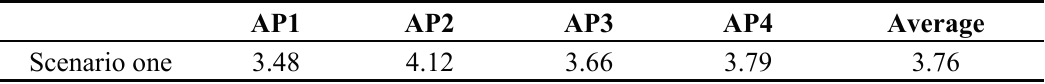
Figure 4. Estimated RSSI errors for testing points in scenario one. ( a ) Estimated Results for AP1; ( b ) Estimated Results for AP2; ( c ) Estimated Results for AP3; ( d ) Estimated Results for AP4 Table 3. RSSI Errors (dBm) in Testing Points in Scenario